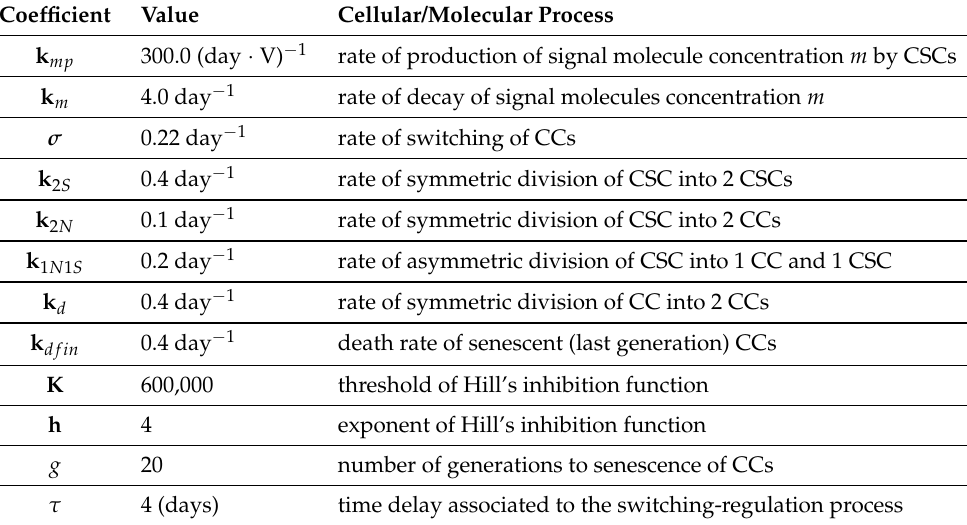
Figure A6. Expression of miRNAs 10b-5p, 15b-5p, 221-3p and 378a-3p for WT ( a ) and Sponge hsa-mir222-5p ( b ) IgR39 cells, compared to the Scramble condition, see Materials and Methods section for details. All comparisons lead to non-significant p -values when using a two-sample t -test. Table A1. Parameters of the model and corresponding molecular/cellular processes.